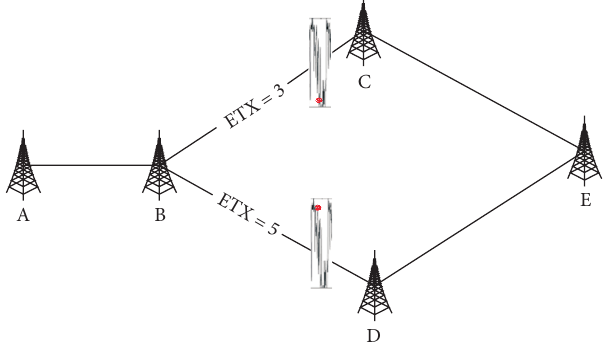
Figure 1: The state of links in data